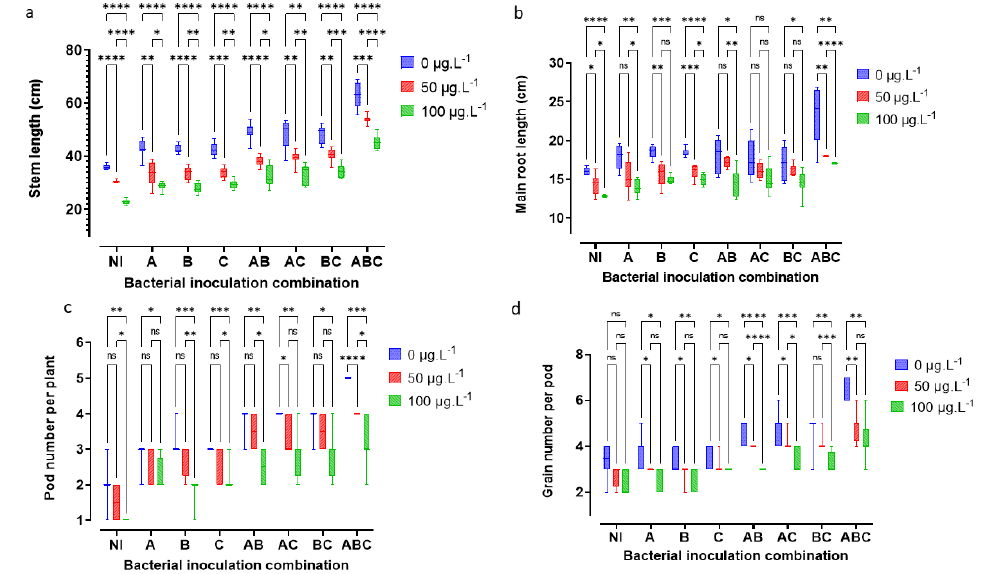
Figure 5. Detrimental impact of MC and beneficial effects of bacterial addition on stem length, SL, in cm ( a ); main root length, MRL, in cm ( b ); number of pods per plant, PNP, ( c ); and number of grains per pod, GNPo, ( d ). The letters NI correspond to the sterile control without bacteria. A = SLB1 is the strain isolated from the Microcystis bloom, B = SLB3 is the strain isolated in MC-contaminated water, and C = RTC10 is the strain isolated in agricultural MC-contaminated soil. The stars correspond to statistical significance at different levels as ns= not significant; * = p < 0.05; ** = p < 0.01; *** = p < 0.001; **** = p < 0.0001.